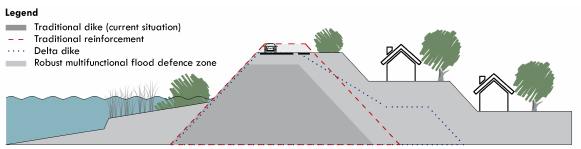
Fig. 3. Cross-section profiles of a current dike, a traditional rein- forcement, a Delta dike and an unbreachable multifunctional flood defense (adapted from Silva and Van Velzen, 2008 and Stowa,